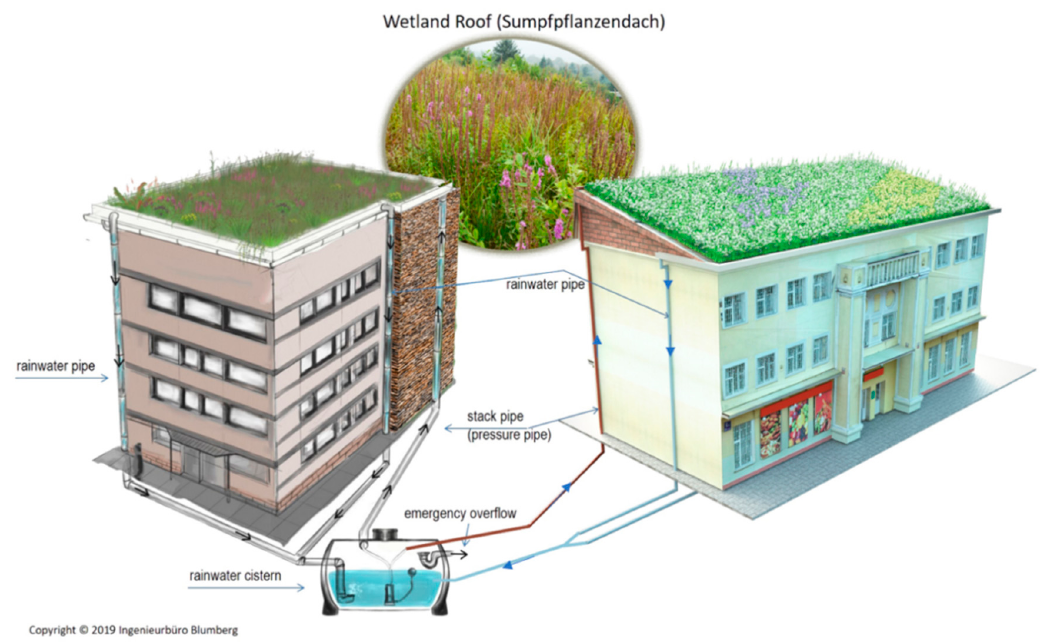
Figure 3. Buildings with wetland roofs for rainwater retention, evapotranspiration or for greywater treatment (graphic: Michael Blumberg). treatment (graphic: Michael